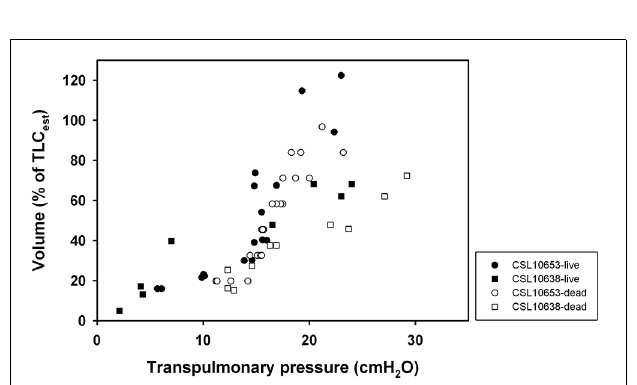
FIGURE 4 | Relationship between transpulmonary (airway pressure minus esophageal pressure) and inspired volume expressed as a percent of estimated total lung capacity (Fahlman et al., 2011) for alive or deceased California sea lions ( Zalophus californianus